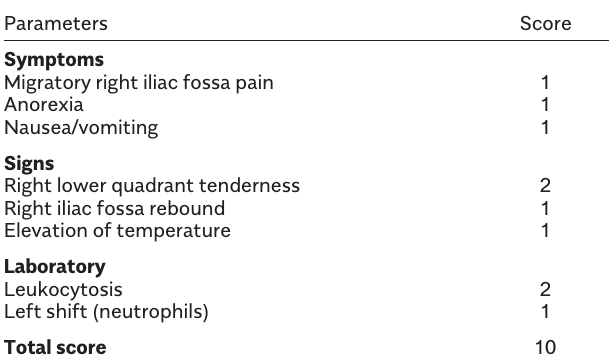
Table 1. Alvarado Scoring System for Acute